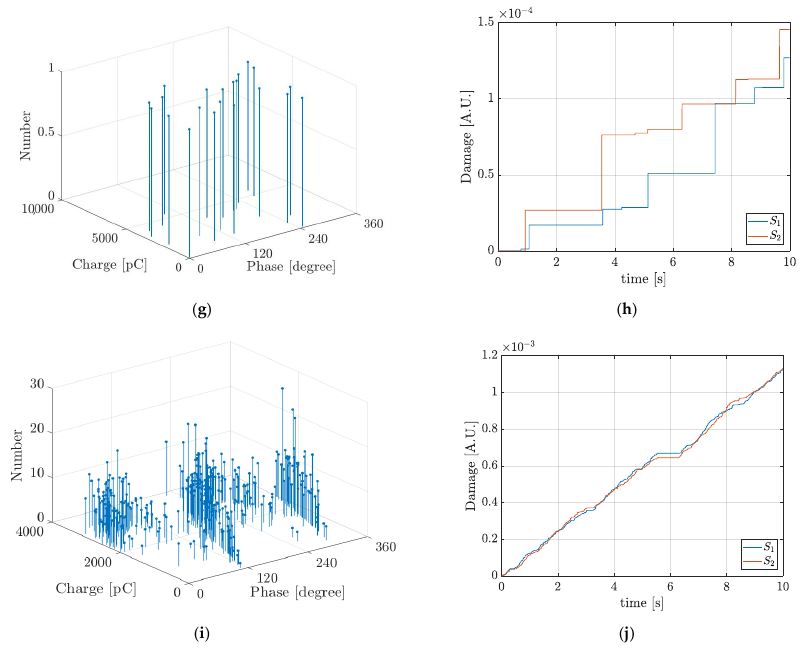
Figure 2. Typical simulation results of Phase-Resolved PD PRPD pattern and accumulated damage function for the five ageing phases in the first case study: ( a ) and ( b ) Phase A; ( c ) and ( d ) Phase B; ( e ) and ( f ) Phase C; ( g ) and ( h ) Phase D and ( i ) and ( j ) Phase E. In Figure 2 “Damage (A.U.)” is the magnitude of the accumulated damage at each separate ageing phase during the simulation time calculated with Equation (5). S 1 and S 2 correspond to the hemispherical surfaces described in Figure 1. In Figure 2 it can be seen that the PD behaviour at each ageing phase: PD rate, charge magnitude and phase distri- bution, is variable and for this reason, as can be inferred from the slopes in the damage curves, the degradation rates are also variable. During the ageing Phase C, Figure 2f, the induced damage is zero. This is because in spite of there are hot electrons during PDs, the electric field strength magnitude in the cavity is very low and those hot electrons are not effective in C-H bonds dissociation, 0 eff F , see Equations (5) and (11). In Figure 2b,f the damage curves S 1 and S 2 are overlapped. In the case of Figure 2b, the overlapping is due to the almost deterministic PDs behaviour at the ageing Phase A, PDs magnitude and rate, independent on the polarity of the applied AC voltage. On the other hand, in the case of Figure 2f, the overlapping is due to the fact that the surfaces S 1 and S 2 are not damaged during the ageing Phase C. Table 2, summarizes the typical simulation results for the num- ber of PDs per cycle, PD N , the estimated life with Equation (6), L (h), and the mean and maximum values of the real, q (pC), and induced, ' q (pC), PD charge at the five ageing phases considered.